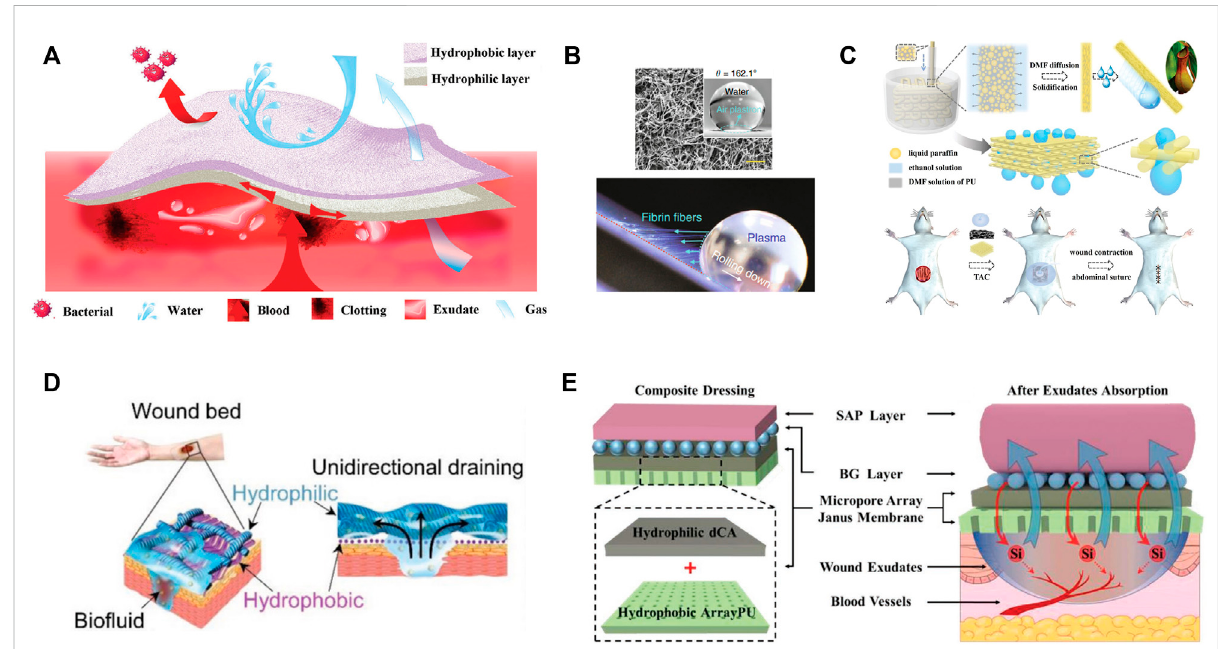
FIGURE 2 (A) Schematic illustration of Janus sponges for wound repair. (B) Super-hydrophobic surface with immobilized carbon nano fi bers for hemostasis. SEM image and water contact angle of the surface (upper), long fi brin fi bers generated when platelet poor plasma droplet rolled down (bottom). (C) Schematic illustration of the fabrication process of the 3D-structured slippery polyurethane textile and application in vacuum sealing drainage therapy. (D) The design of self-pumping dressing by exudate drainage. (E) Scheme of four-layer wound dressing with properties of self-pumping and ion back fl